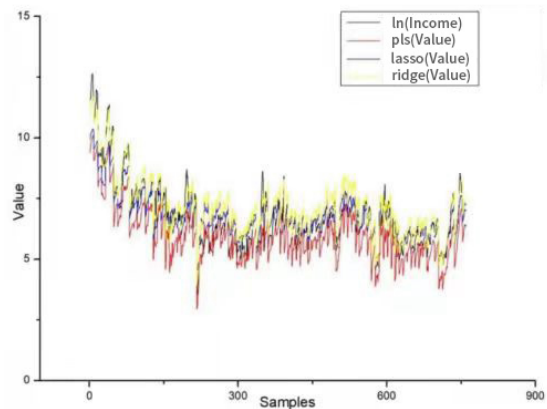
Figure 2. Predicted values of four variables.